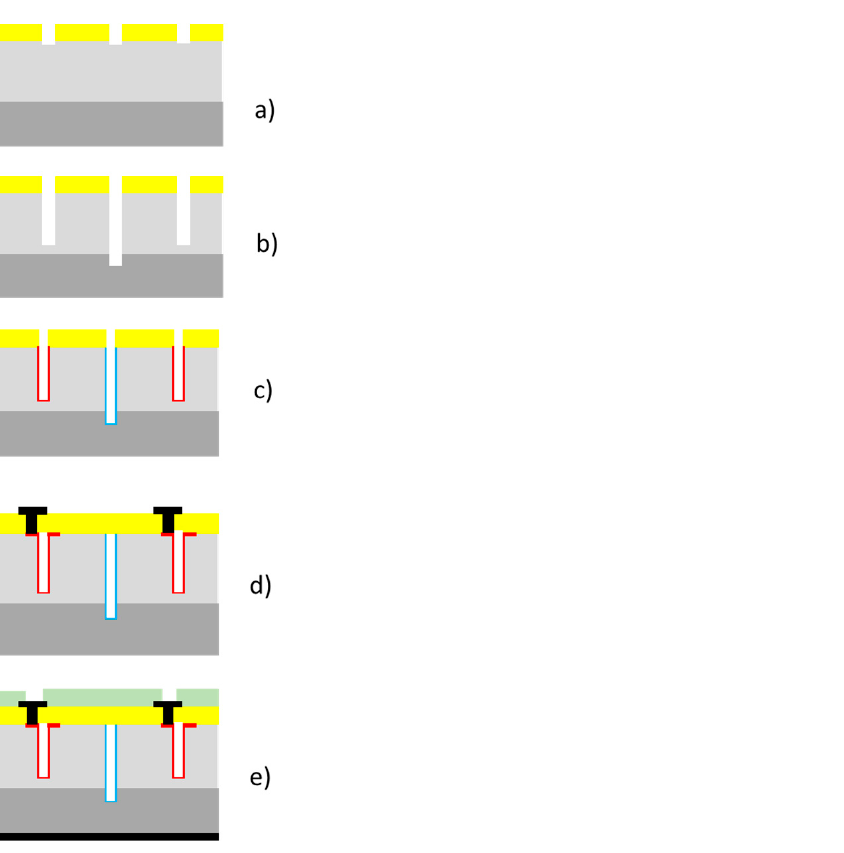
Figure 3. Process description of 3D a-Si:H detector fabrication (option 2); lithographic steps are omitted. ( a ) Silicon nitride passivation layer deposition and patterning for the DRIE process. ( b ) P- hole and n-hole etching. ( c ) Columns doping by ion implantations. ( d ) Opening of contacts, metal deposition, and etching. ( e ) Deposition and patterning of passivation layer and deposition of backside